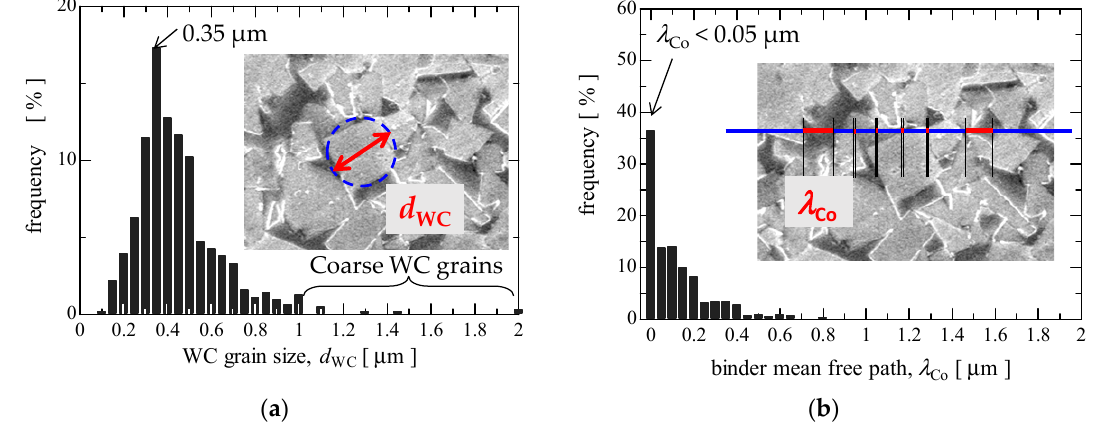
Figure 2. Histograms of: ( a ) WC grain size; ( b ) Binder mean free path.